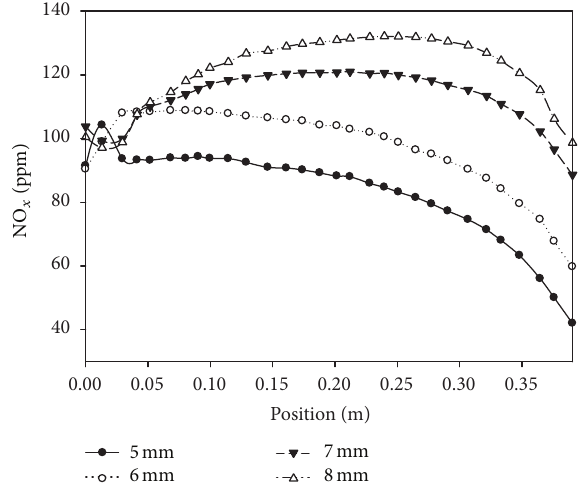
The reaction rate constants are calculated by